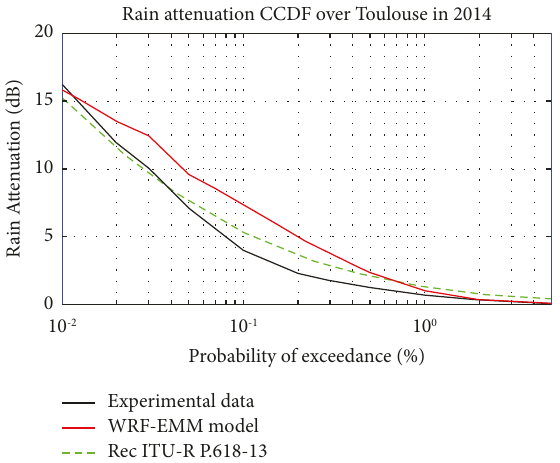
Figure 6: Comparisons between CCDFs computed from data measured in Aveiro in 2014 (99.1% availability), WRF-EMM simulations and Rec. ITU-R P.618–13 using R 0.01 predicted with Rec. ITU-R P.837–7.